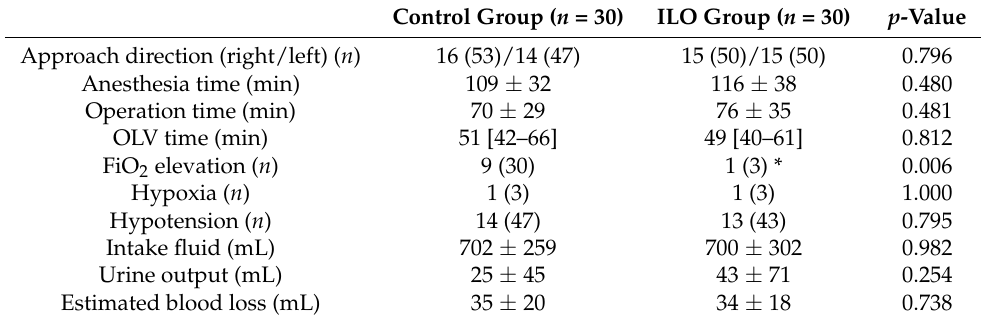
Table 2. Intraoperative data.